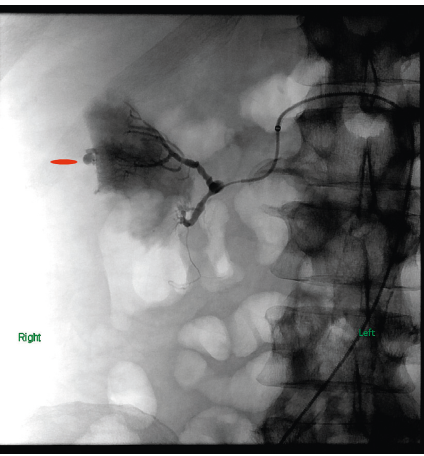
Figure 3: Selective right renal angiogram showing renal artery branch aneurysm with extravascular leakage of contrast.